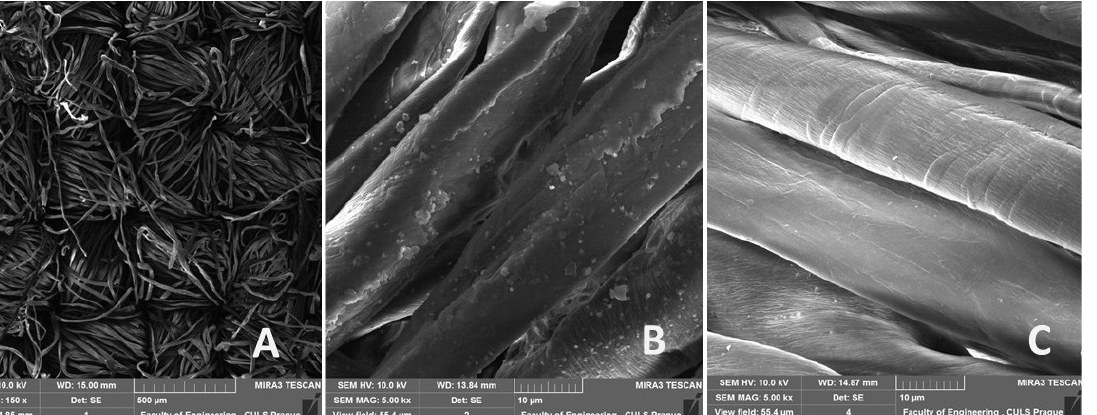
Figure 9. Viscoelastic behavior of adhesive bonds with reinforcing fabric Tera and different shapes during 5–50% cyclic load.